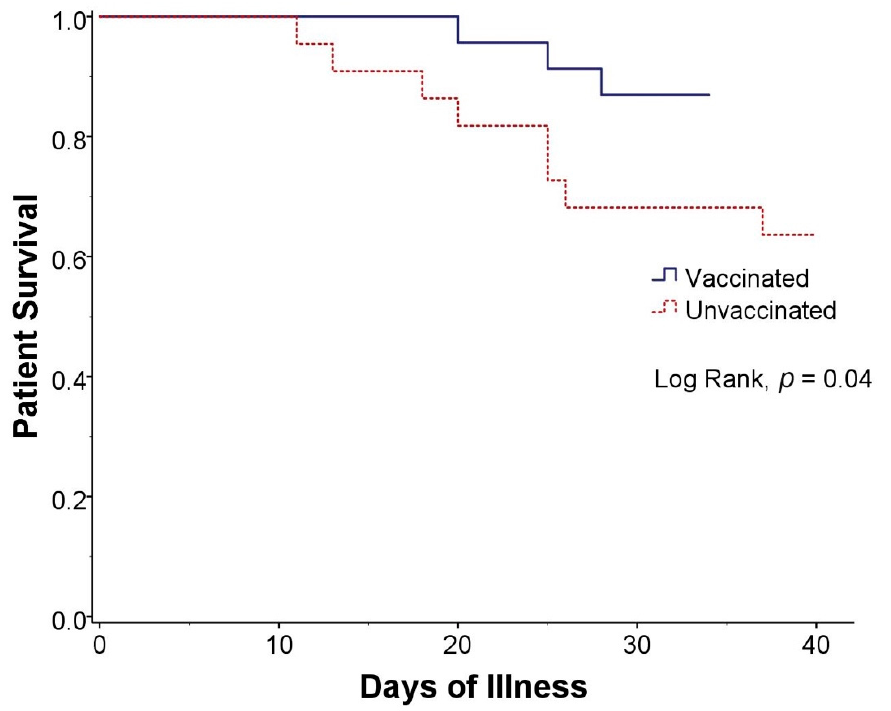
Figure 1. Kaplan-Meier curve of survival in kidney transplant recipients with COVID-19 infection who were vaccinated (blue solid line) and unvaccinated (red dashed line). Table 3. Outcomes of COVID-19 infection in kidney transplant recipients classified by vaccination